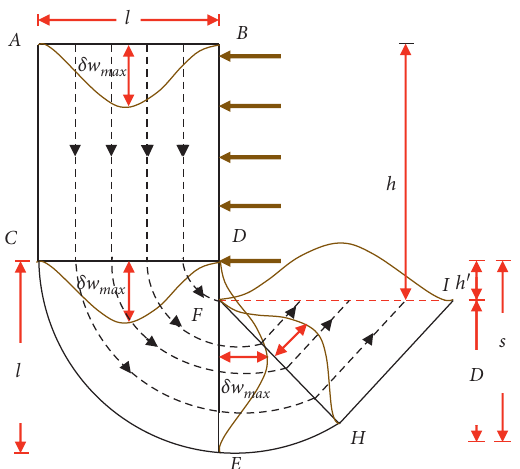
Figure 3: Deformation increment mechanism of the internal support foundation pit.